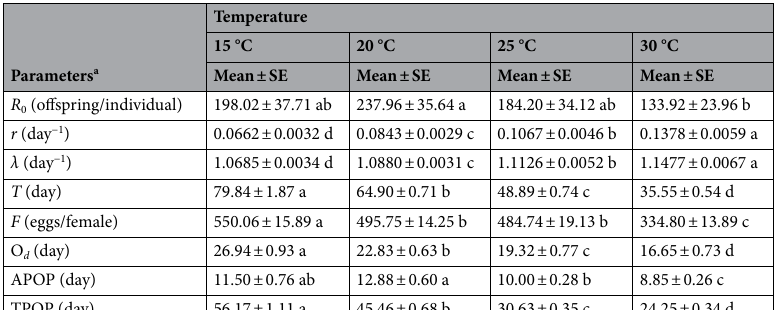
Table 2. Reproduction and population parameters (Mean ± SE) of Harmonia axyridis fed on Spodoptera litura eggs at four different temperatures. Standard errors were estimated by using the bootstrap technique with 100,000 resampling. Difference was compared using the paired bootstrap test ( P < 0.05). The means within a row followed by a different lowercase letters indicate significant differences among the temperatures. APOP adult preoviposition period, TPOP total preoviposition period. a R 0 = net reproductive rate; r = intrinsic rate of increase; λ = finite rate of increase; T = mean generation time; F = fecundity; O d = oviposition